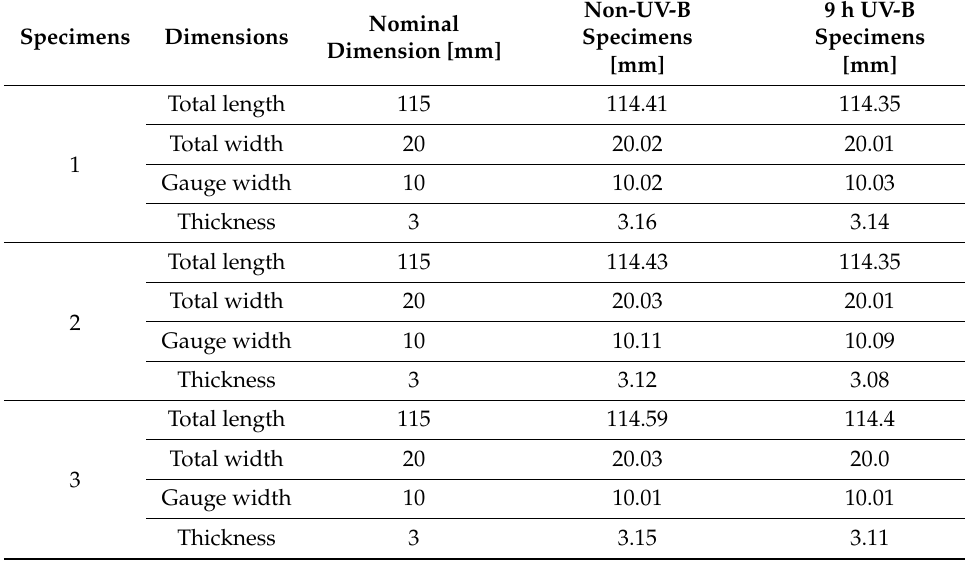
Figure 7. Three-dimensional-printed PCL samples. Thermoforming results: melted sample ( a ); open pocket sample with fractures caused by the deformation attempts ( b ); lower infill density sample with fracture line caused by deformation ( c ). Table 2. Dimensions of specimens (nominal, 3D printed, and UV-B